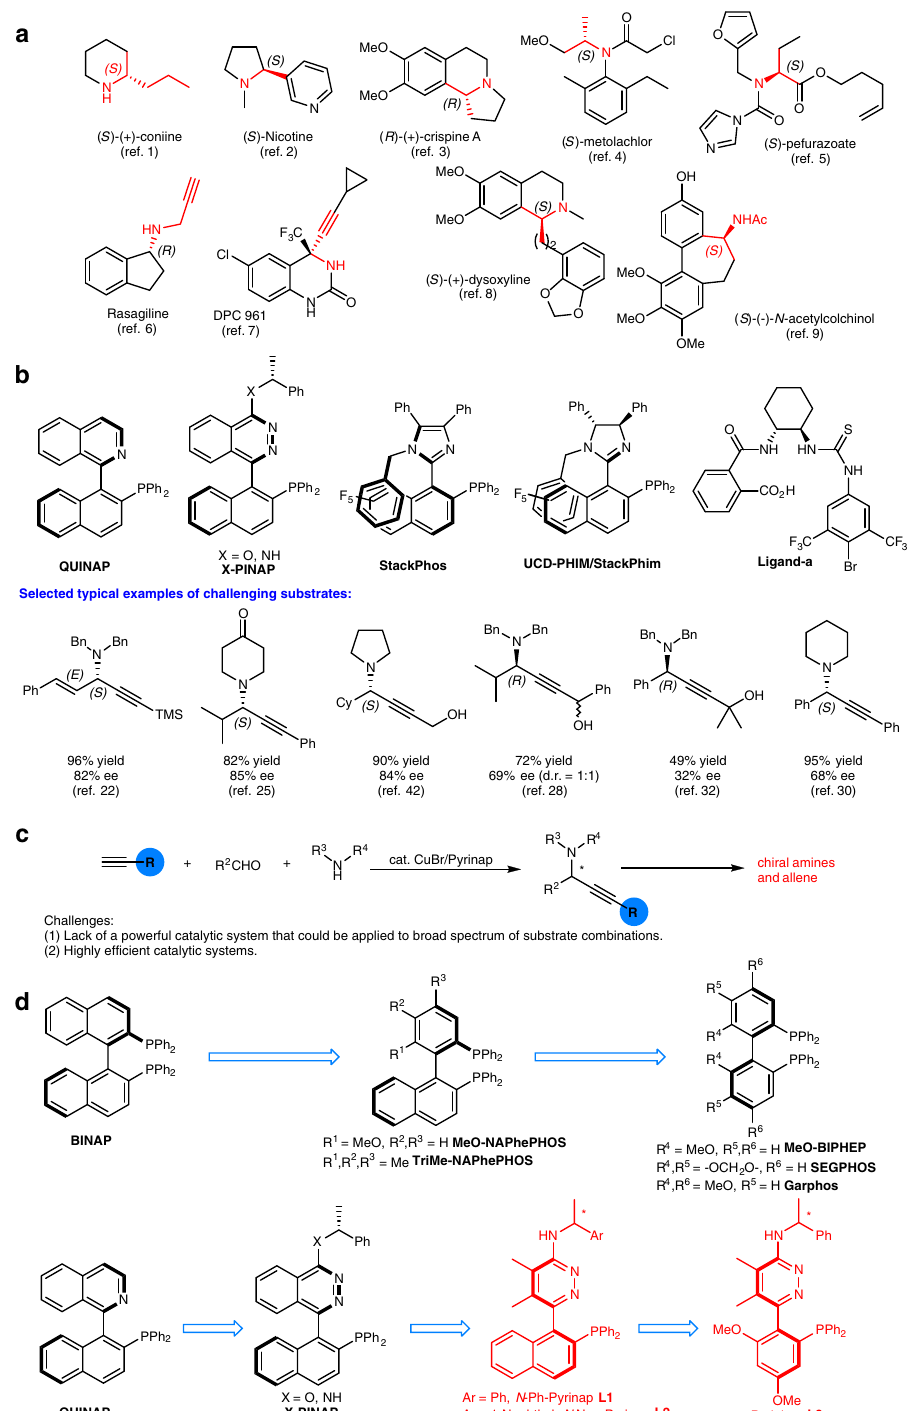
Fig. 1 Background and concept design. a Selected biologically active chiral amines. b Known ligands for catalytic enantioselective A 3 -coupling reactions. c The method developed in this study. d Conceptual advance: evolution of binaphthyl to phenyl-naphthyl to biphenyl bisphosphines and the design of Pyrinap and